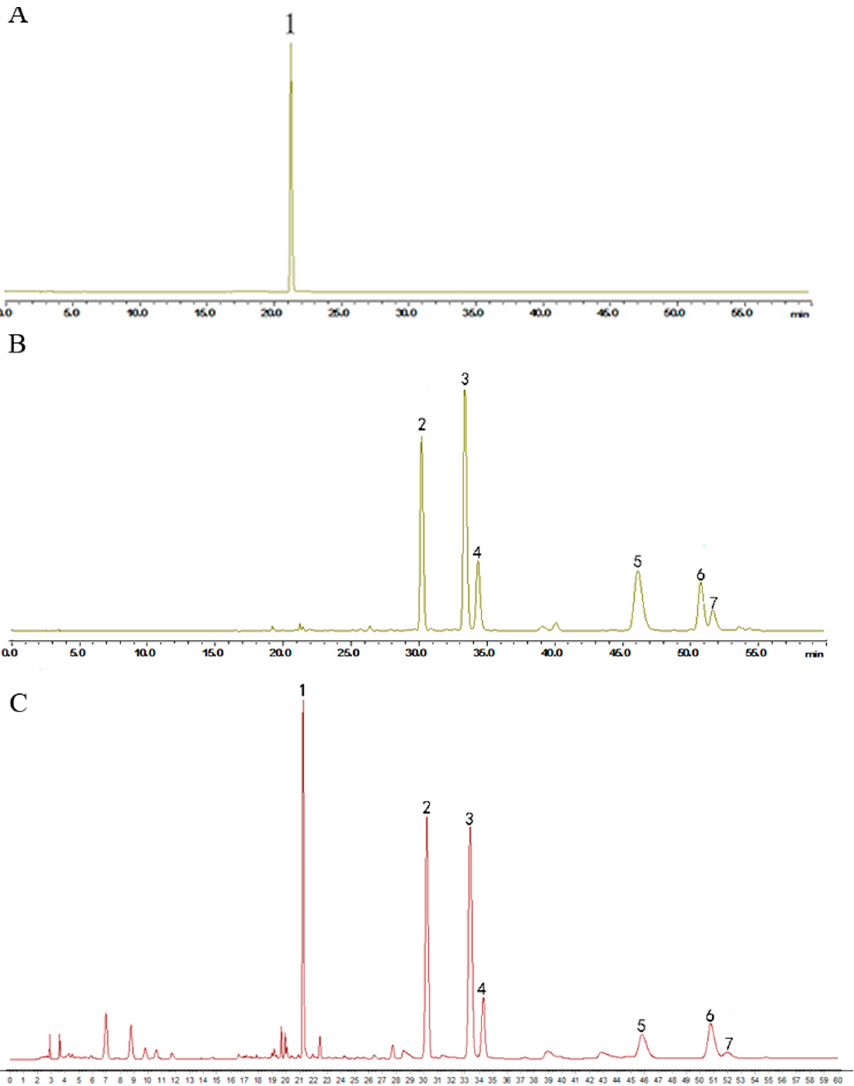
Figure 7. HPLC chromatogram of ( A ) xantholhumol; ( B ) the mixed standard control and ( C ) the hops extract. The content of xanthohumol in the extract was 0.55%. (1. xanthohumol; 2. cohumulone; 3. humulone; 4. adhumulone; 5. colupulone; 6. lupulone; 7. adlupulone.)